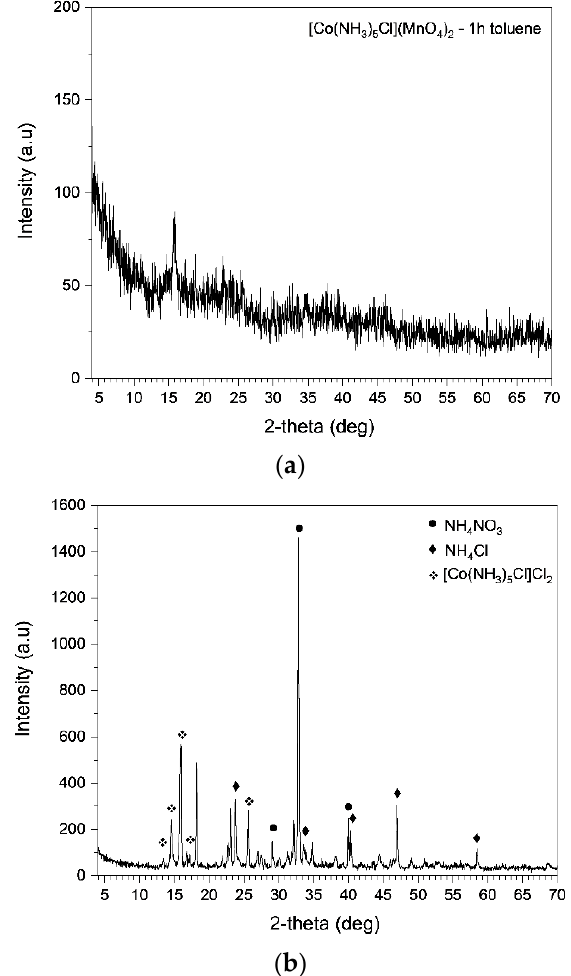
Figure 10. ( a ) XRD of the decomposition product of compound 3-Mn after 1 h reflux in toluene and ( b ) XRD of the dried aqueous extract of the thermal decomposition product formed under toluene. Separating the amorphous reaction product into water-soluble and insoluble (ox- ide) parts and evaporating the aqueous leachate, we assigned the water-soluble compo- nents by powder XRD and IR as NH4NO3, [Co(NH3)5Cl]Cl2 (compound 4) and a small amount of NH4Cl (Figure 10). The NH4Cl was probably formed as a hydrolysis product of compound